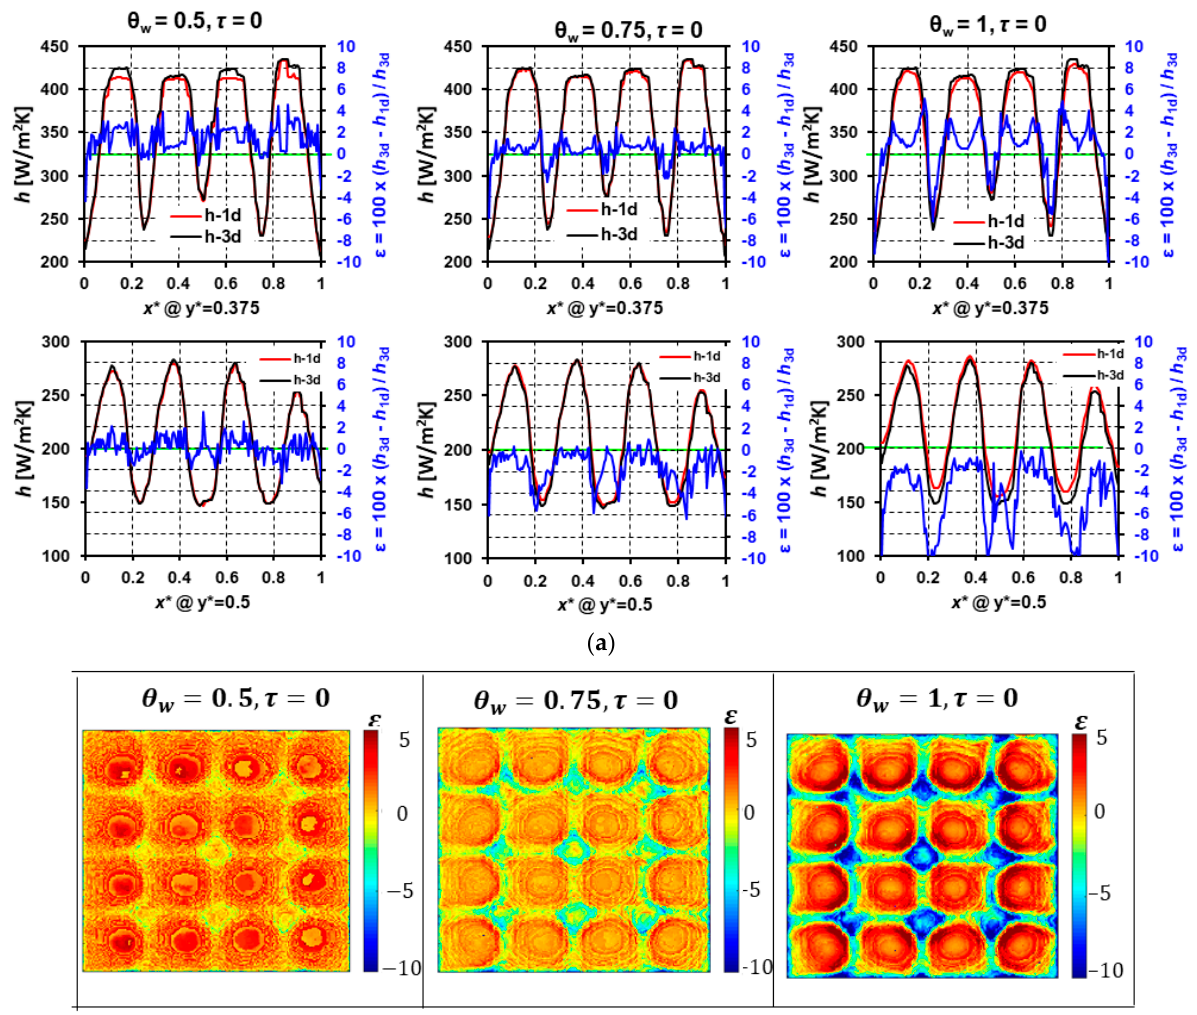
Figure 14. Method C, Case III: ( a ) Local h variation at y* = 0.375 and y* = 0.5 and their relative % differences, ( b ) 𝜀 map for three different wall temperature tracking.